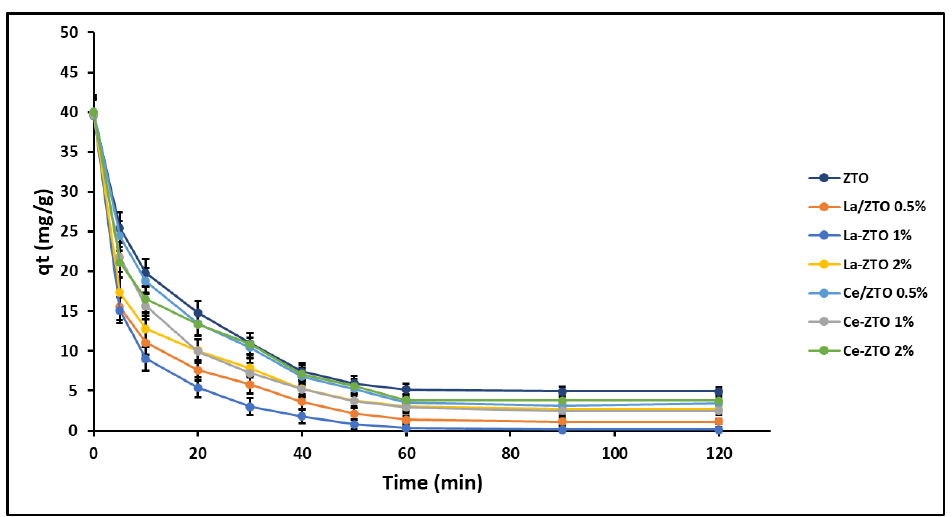
Figure 4. Cyanide adsorption capacity as a function of nanoparticles’ composition.